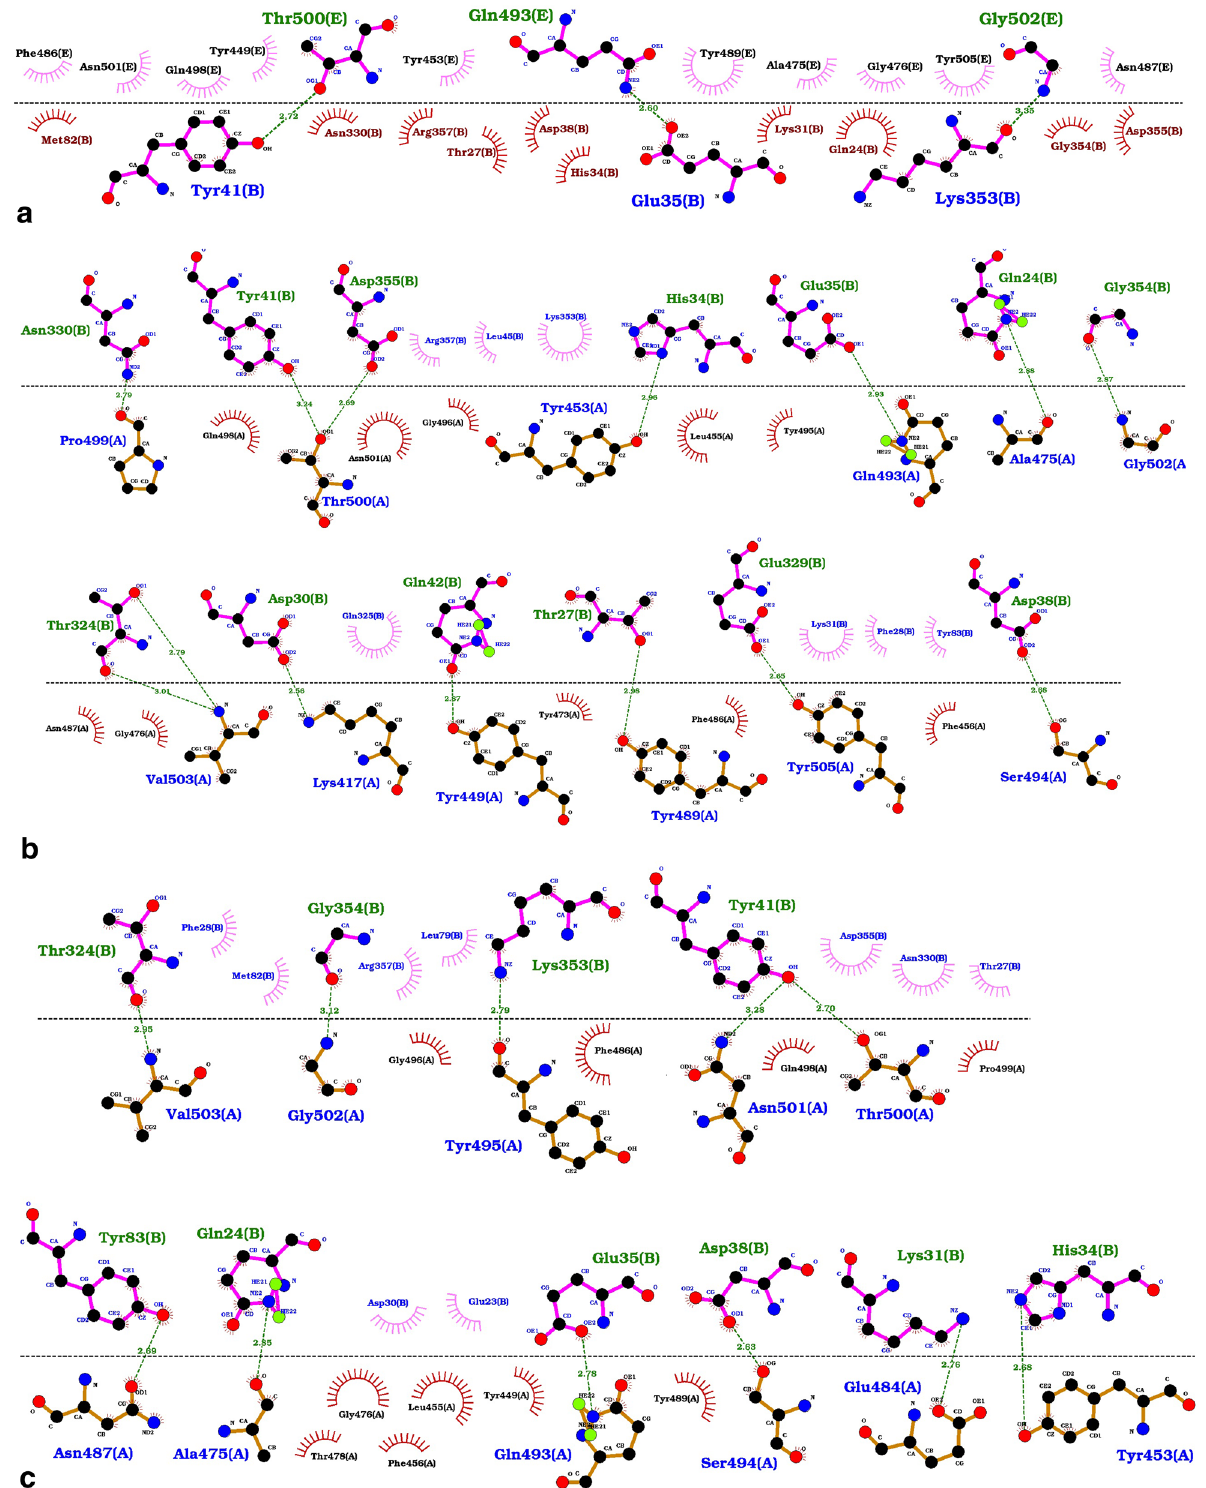
Figure 6. Spike-ACE2 interaction details. The hydrogen and hydrophobic bonds within different ACE2-Spike protein complexes. The ACE2 residues have been labeled by “B” letter and the Spike protein residues have been shown by “A”. The green line represents the hydrogen bonds. Residues involved in hydrogen bonds have been shown in blue and green colors, while brown and black colors are used for hydrophobic interactions. The length of the hydrogen bonds is determined by the angstrom. ( a ) Experimental 6M17chainB-6M17chainA complex; ( b ) Simulated Spike-ACE2 complex; ( c ) Simulated Spike-ACE2(Lyz26 >Arg) complex; ( d ) Simulated Spike- ACE2(Ser331 >Phe)